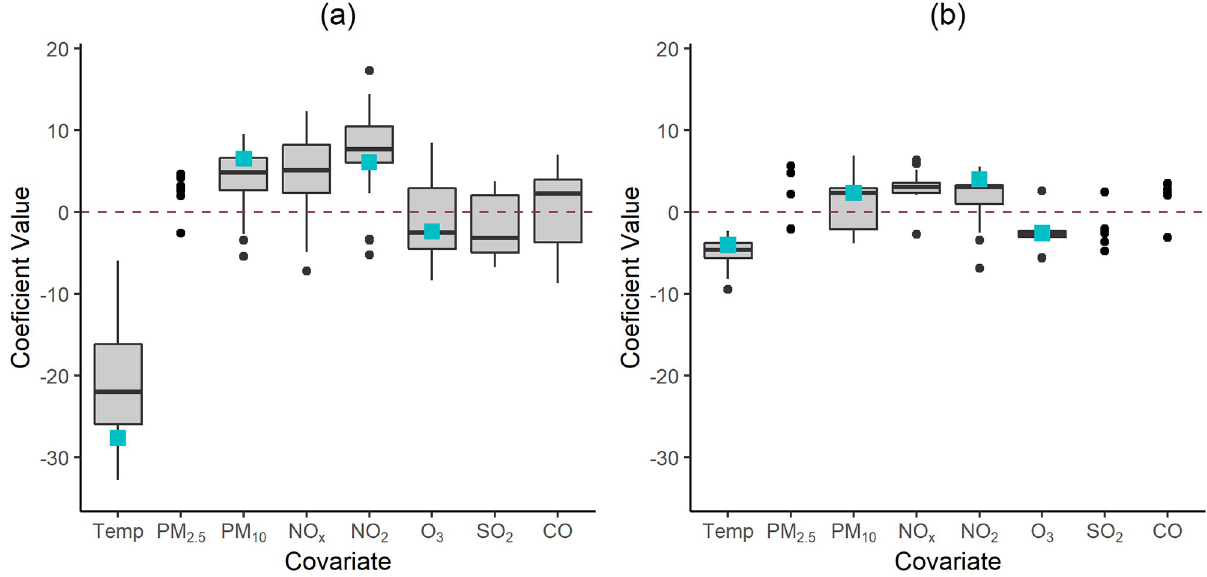
Fig 7. Distribution of the scaled coefficients according to each covariate. (a) M R and (b) M F models. Boxplots are presented when there are at least 15 locations otherwise each dot represents a location. The blue squares identify the coefficients estimated for Valongo (VALO) location.